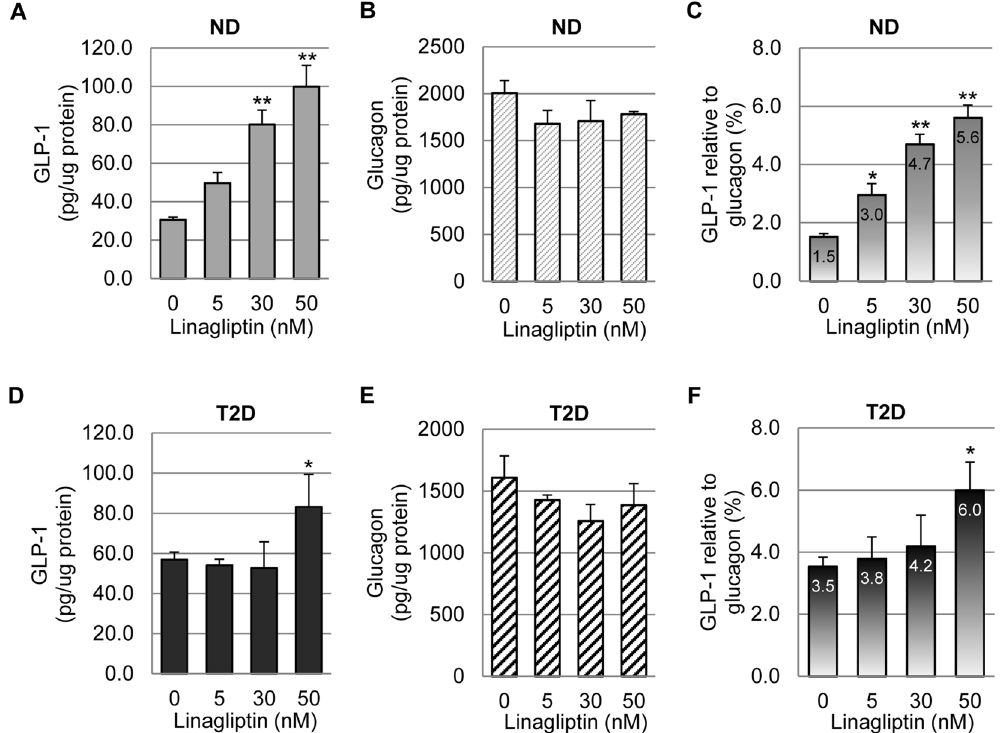
Figure 5. GLP-1 and glucagon production in human islets treated with linagliptin. Following 3-day linagliptin treatment, ND ( A–C) and T2D ( D – F ) human islets were collected and lysed. GLP-1, glucagon, and total proteins were measured. The amounts of GLP-1 and glucagon were normalized with total protein. Relative GLP-1 to glucagon production was calculated by dividing the GLP-1 amount by the glucagon amount in the same sample, and then expressed in percentage format ( C , F ). * p < 0.05; ** p < 0.01 compared to untreated